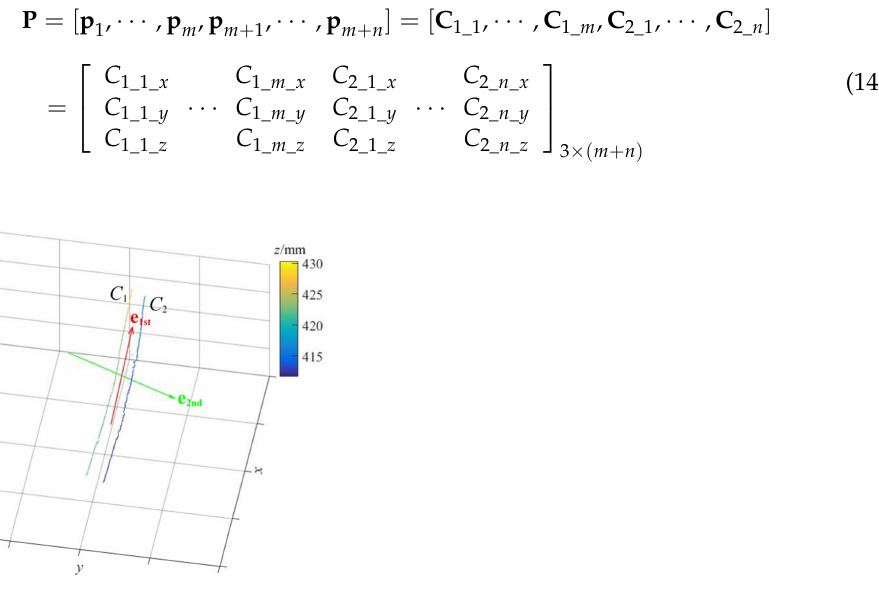
Figure 6. The visualization of the direction of the rip; the color bar corresponds to the z coordinate values. Next, the PCA algorithm is used to determine the principal component vectors ( e 1st and e 2nd ) of the distribution of P